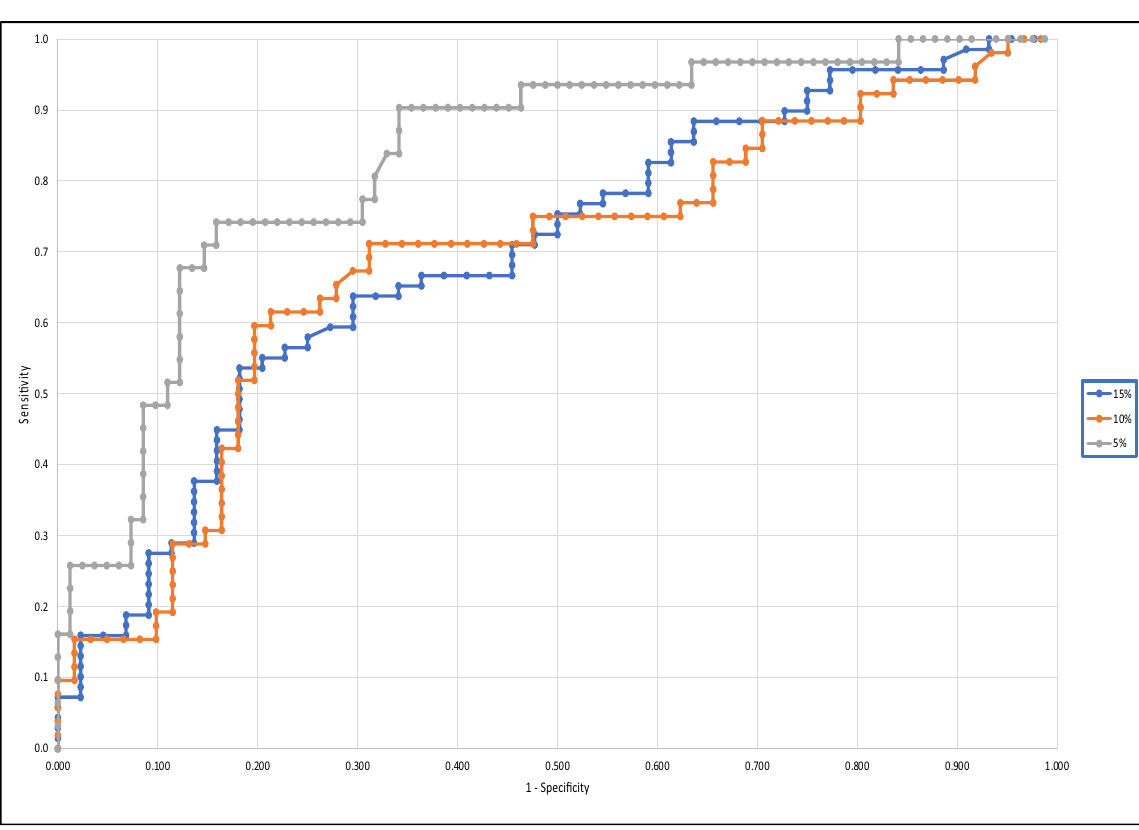
Figure 4. ROC curve demonstrating the clinical utility of faecal bile acid measurement for diagnosing severe bile acid diarrhoea (defined as SeHCAT retention of ≤ 5%), severe or moderate bile acid diarrhoea (defined as SeHCAT retention of ≤ 10%), and severe, moderate or mild bile acid diarrhoea (defined as SeHCAT retention of ≤